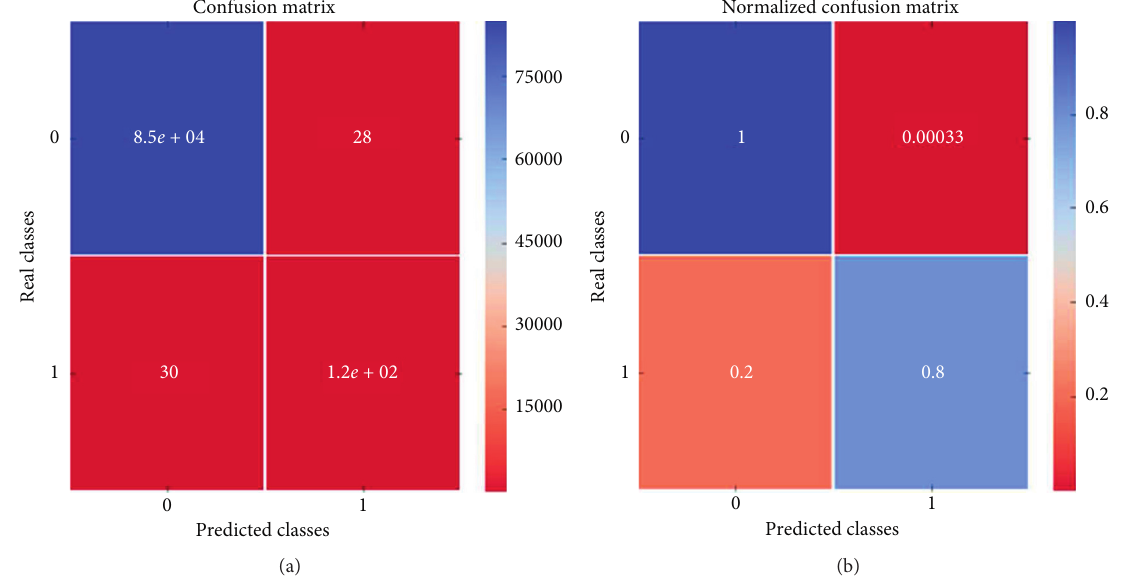
Figure 11: (a) Confusion matrix and (b) normalized confusion matrix for borderline-SMOTE +LSTM.